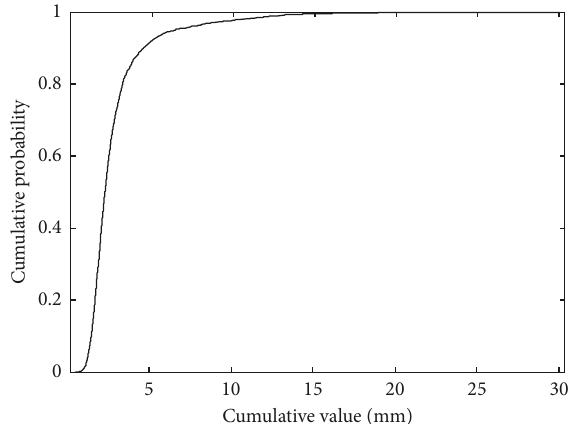
Figure 9: The cumulative probability of N